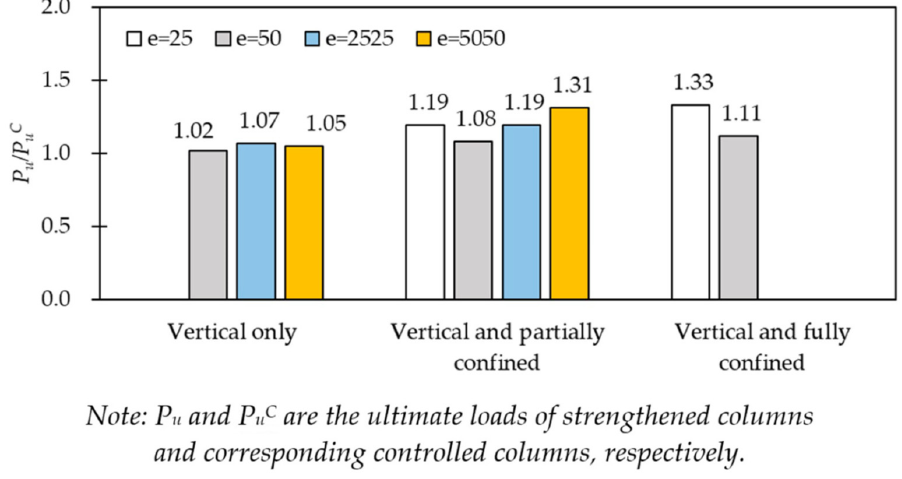
Figure 12. CFRP strengthening